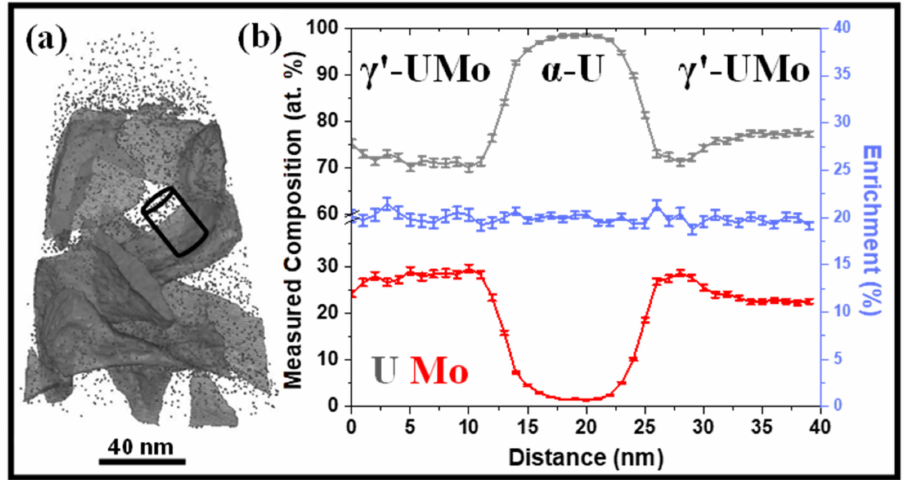
Figure 3. ( a ) 3D distribution of network of α -U (grey color) shown with 100 at.% iso-concentration surfaces, ( b ) 1D profile taken across the lamellar structure by placing a cylinder (shown in ( a )) across the interface. (blue: enrichment, red: Mo, grey: